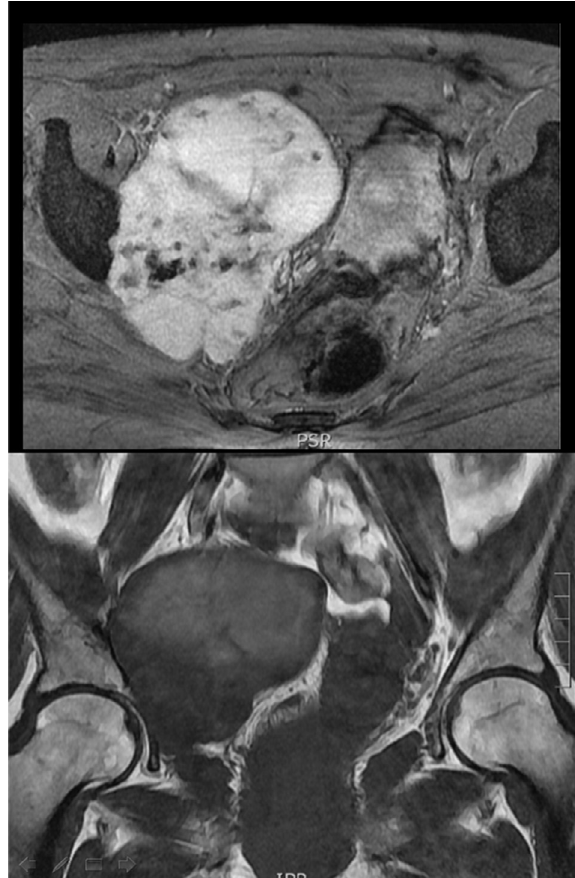
Figure 1. Magnetic resonance imaging (MRI) showing a poly- lobulated mass of soft tissue (11.2 · 7.6 · 9.1 cm) in the right obturator foramen affecting the internal obturator muscle with erosion of the